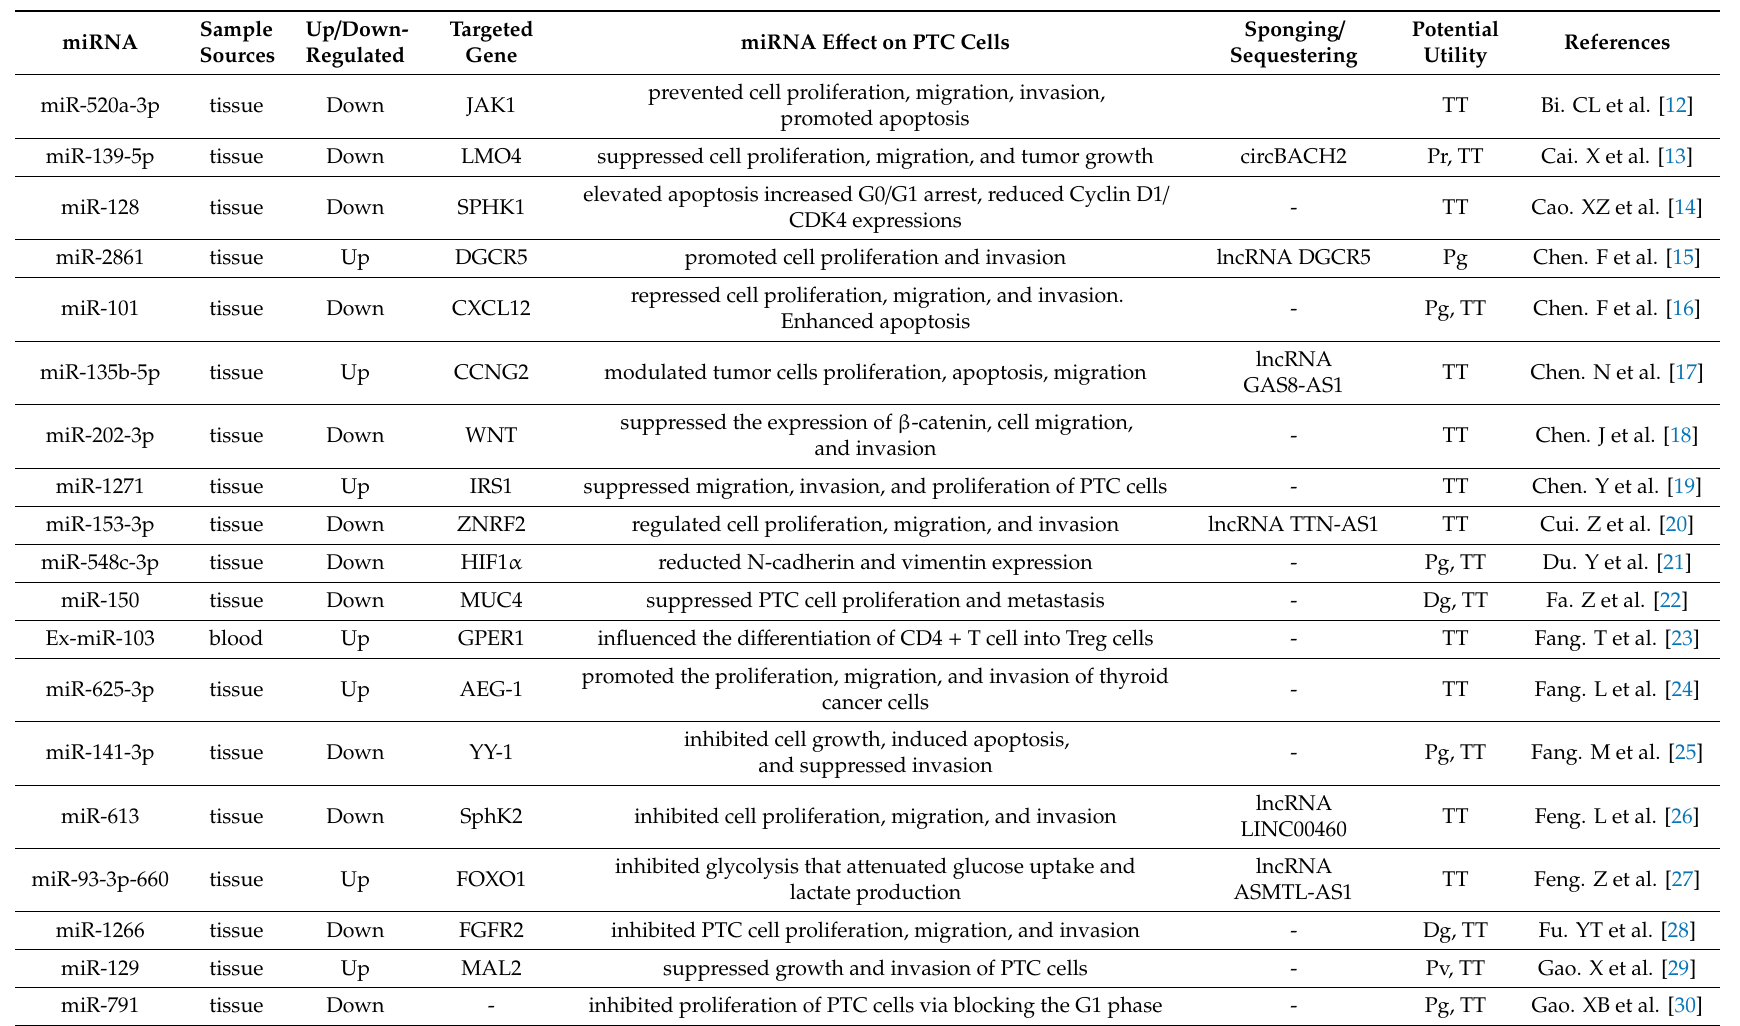
Table 1. Targets of epigenetic alterations in papillary thyroid carcinoma